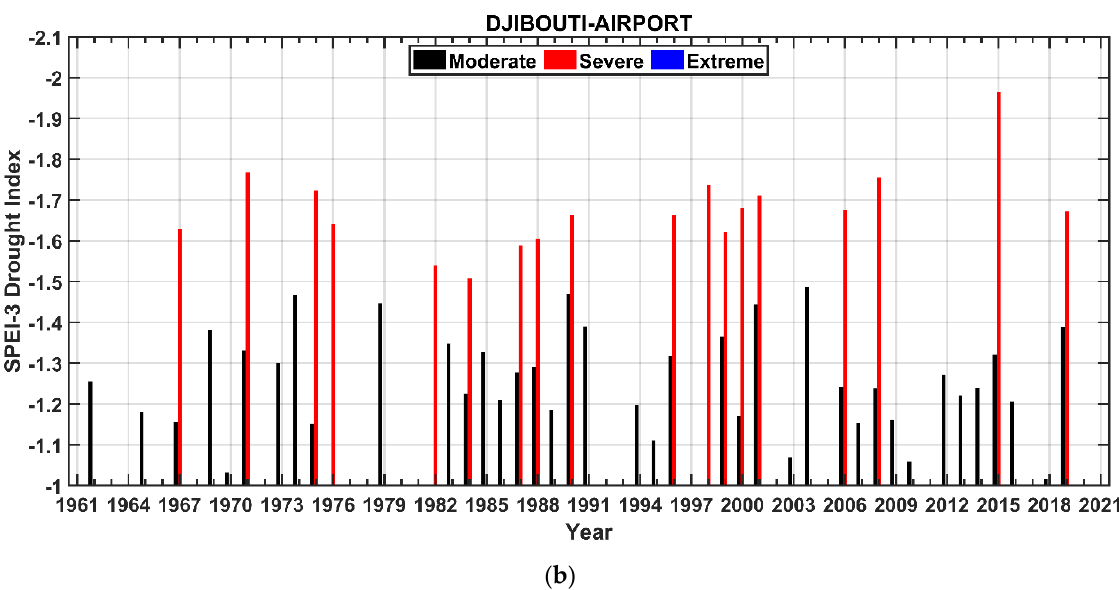
Figure 7. Temporal variation of SPI ( a ) and SPEI ( b ) at a 3-month timescale for moderate, severe, and extreme drought events at Djibouti Airport from 1961 to 2021.